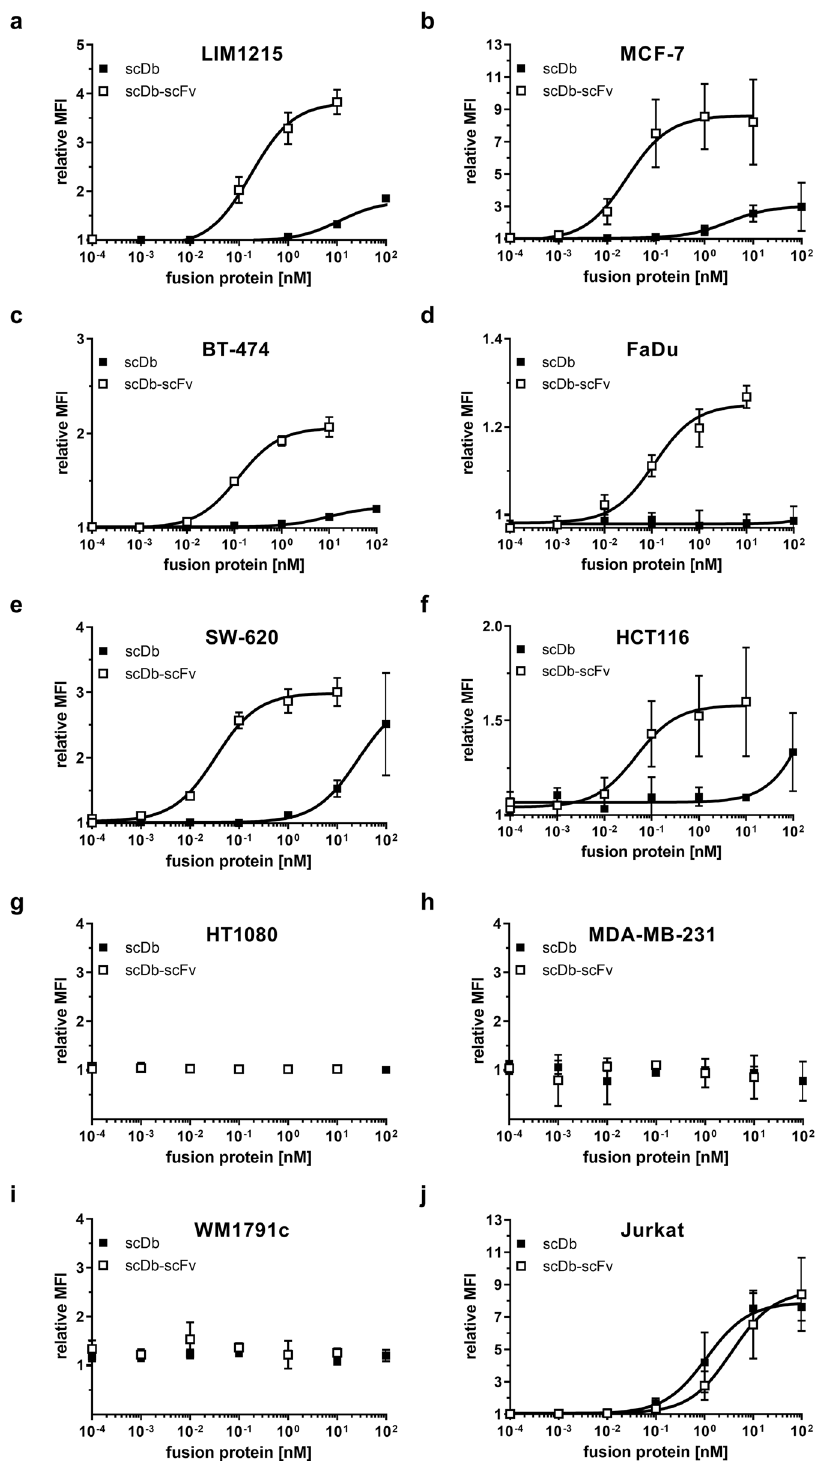
Figure 2. Binding properties of scDb and scDb-scFv. Binding to ( a ) LIM1215, ( b ) MCF-7, ( c ) BT-474, ( d ) FaDu, ( e ) SW-620, ( f ) HCT116, ( g ) HT1080, ( h ) MDA-MB-231, ( i ) WM1791c and ( j ) CD3-expressing Jurkat cells was analyzed in flow cytometry. Bound protein was detected using a PE-labeled anti-His mAb. Mean ± SD, n =